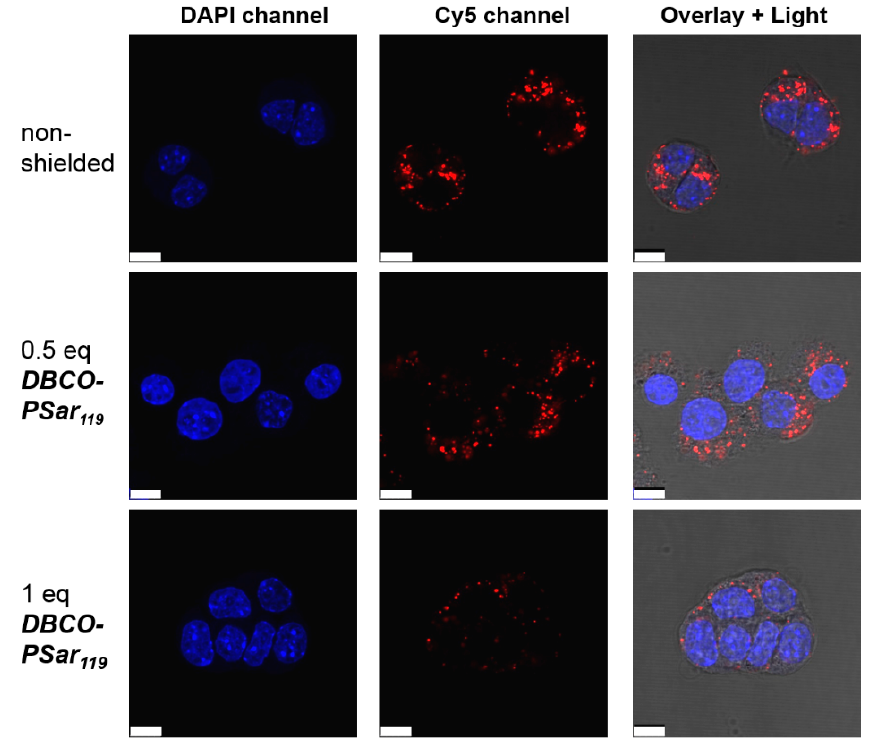
Figure 3. Intracellular distribution of T-1N 3 siRNA formulations in Neuro2a-eGFP-Luc cells with increasing equivalents (eq mol/mol) of DBCO-pSar 119 acquired with a confocal laser scanning microscop. Cells were incubated with the formulations for 4 h and washed with PBS buffer. siRNA was spiked with 20% Cy5-labeled siRNA (red), nuclei were stained with DAPI (blue). The overlay image shows the light microscope image and the merged DAPI and Cy5 channels. Scale bar: 10 µm.